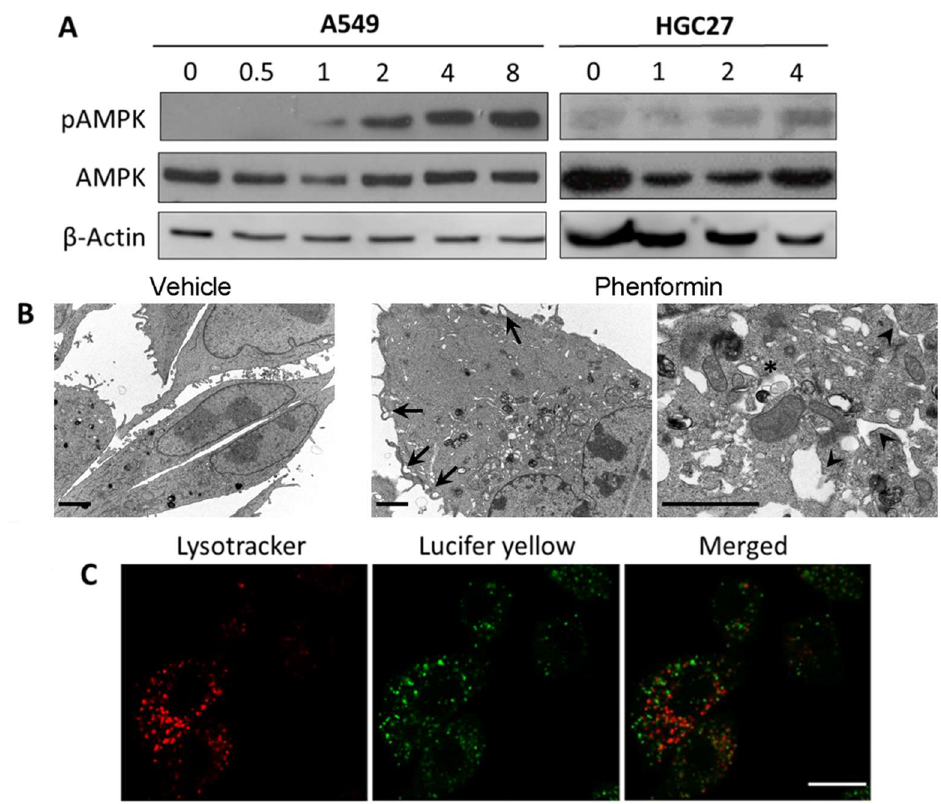
Figure 6. ( A ) A549 and HeLa cells treated with vehicle (0, 0.05% EtOH 24 h) or 5 µM JB at the indicated times (h) were lysed, and the levels of total and phosphorylated 5' AMP-activated protein kinase (AMPK) were analyzed by immunoblotting. β-Actin was used as loading control. Results are representative of two to three independent experiments. ( B ) A549 cells were treated with 0.05% ethanol or 10 mM phenformin for 4 h. Arrows show membrane extensions, the asterisk shows endolysosome accumulation indicating defective endocytic flux, and the arrowhead, dilated ER. Scale bars: 2 µm. ( C ) A549 cells treated with 10 mM phenformin and 0.5 mg/ml of LY for 4 h. 75 nM lysotracker was added 0.5 h prior to visualization. Cells were observed under confocal microscopy. Scale bar: 10 µm. Images are representative of two experiments in duplicate.